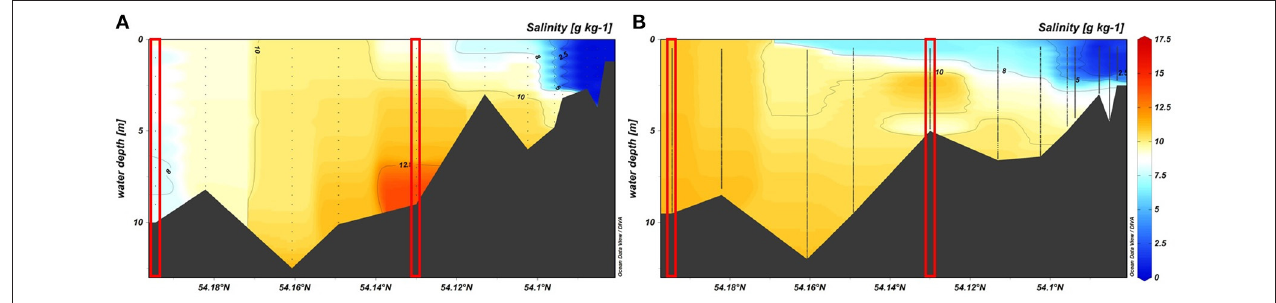
FIGURE 4 | Salinity profiles in the Warnow estuary in (A) February 2017 and (B) June 2017; red lined boxes mark the stations “Baltic Sea” and “Hundsburg”.